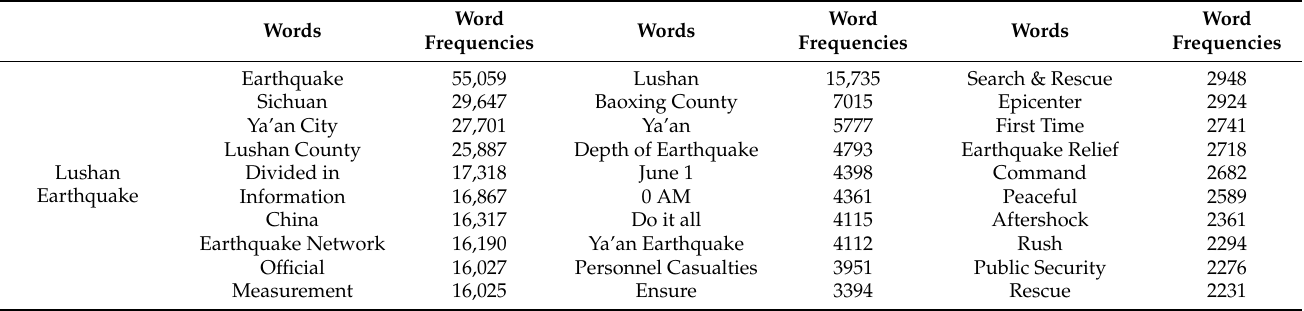
Table 2. Frequency statistics of words in microblogs posted 24 h after the earthquake (top